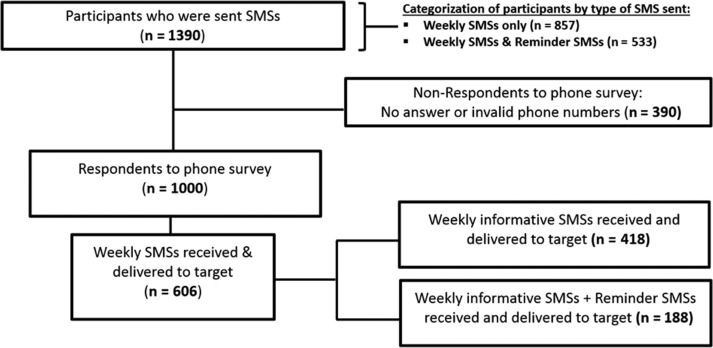
Participant flow.